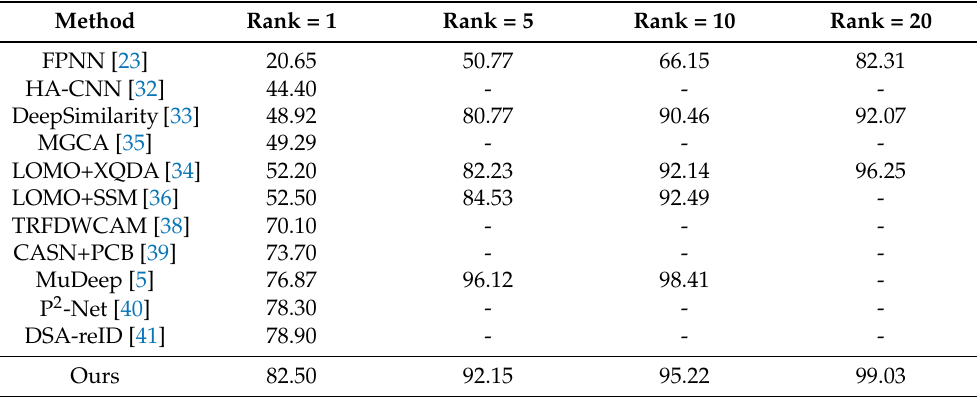
Table 3. Experimental results for CUHK-03 on the labeled